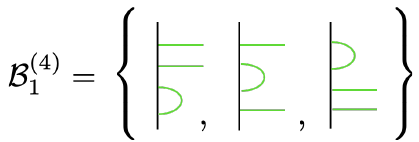
Figure 26 . All the possible (4 , 1) -link